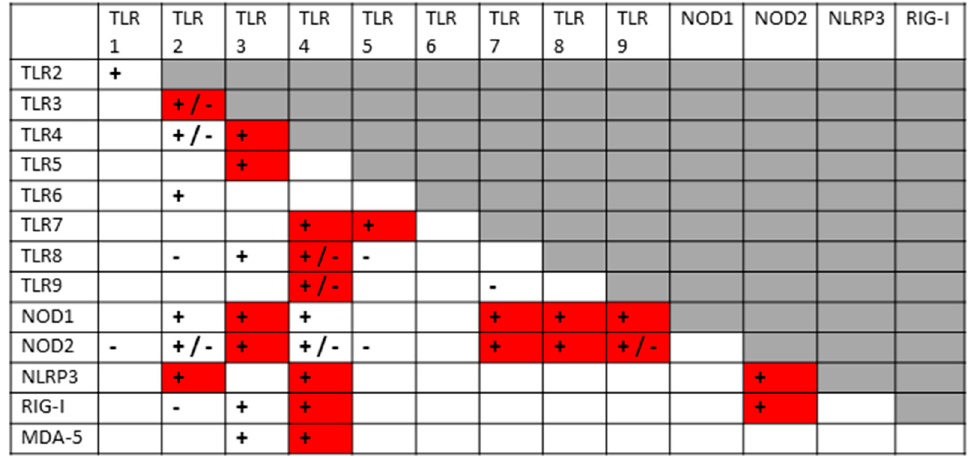
Figure 2. Summary of currently known synergisms (+), antagonisms ( − ) and cases where pretreat- ment (usually several days or more in advance of the second stimulus) by one receptor agonist results in antagonism to the other, whereas co-stimulation results in synergism (+/ − ). Synergies involv- ing virus-activated receptors (TLR3, TLR7, TLR8, TLR9, RIG-I or MDA-5) with bacteria-activated receptors (TLR2, TLR4, TLR5, NOD1 or NOD2) are highlighted in red because these are of particular importance for understanding how co-infections between SARS-CoV-2 and bacteria may result in increased inflammation. Blank boxes indicate that activators of the pair of TLRs or NLRs do not synergize, or that no studies of their possible synergy could be found. The gray boxes are blocked out because they duplicate the red and white boxes. The Figure is based on an integration of hundreds of studies provided in two recent reviews [1,2], supplemented with several additional sources [5–12]. The full set of original references is appended as a Supplementary References in Appendix